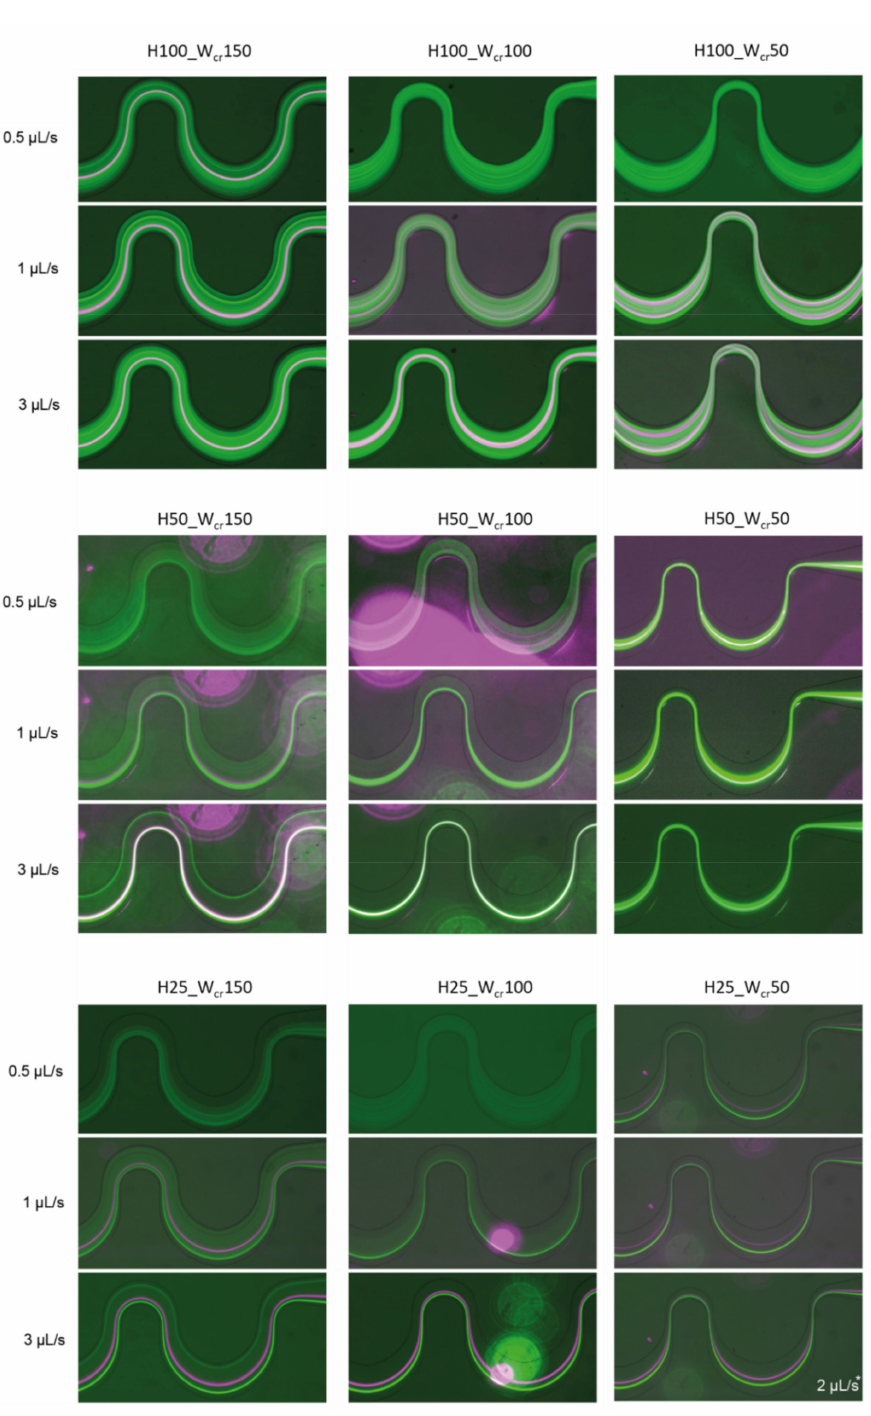
Figure A1. 8 µ m (green), 15.8 µ m (purple) in channel having height of (H) 100–50–25 µ m and the critical width (C) 150–100–50 µ m at flow rates 0.5–1–3 µ L/s. In case of H25_C50 the maximum flow rate could not be set higher than 2 µ L/s without